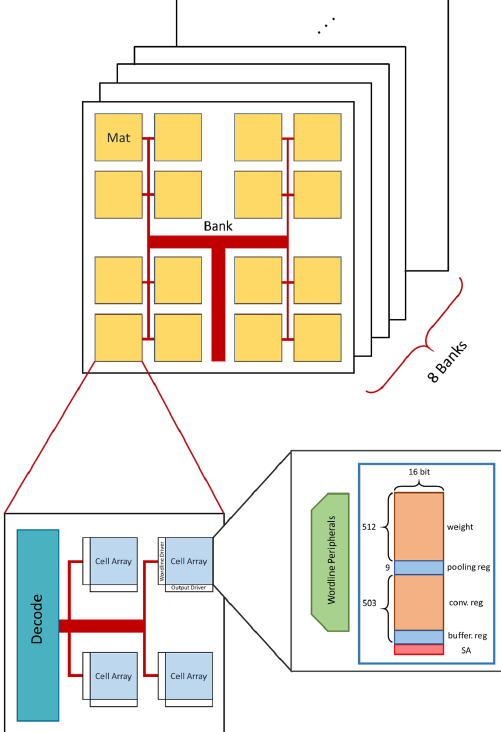
Figure 5. Circuit architecture of